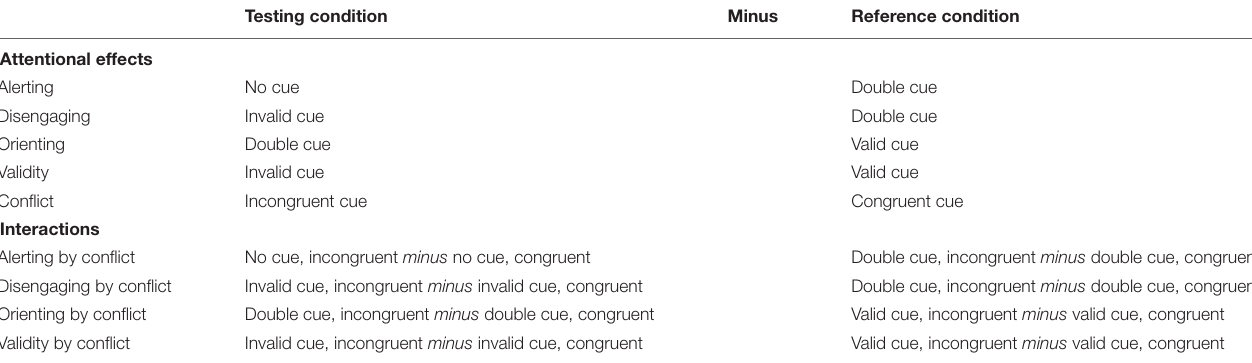
TABLE 1 | Operational definitions of the attentional effects and interactions.